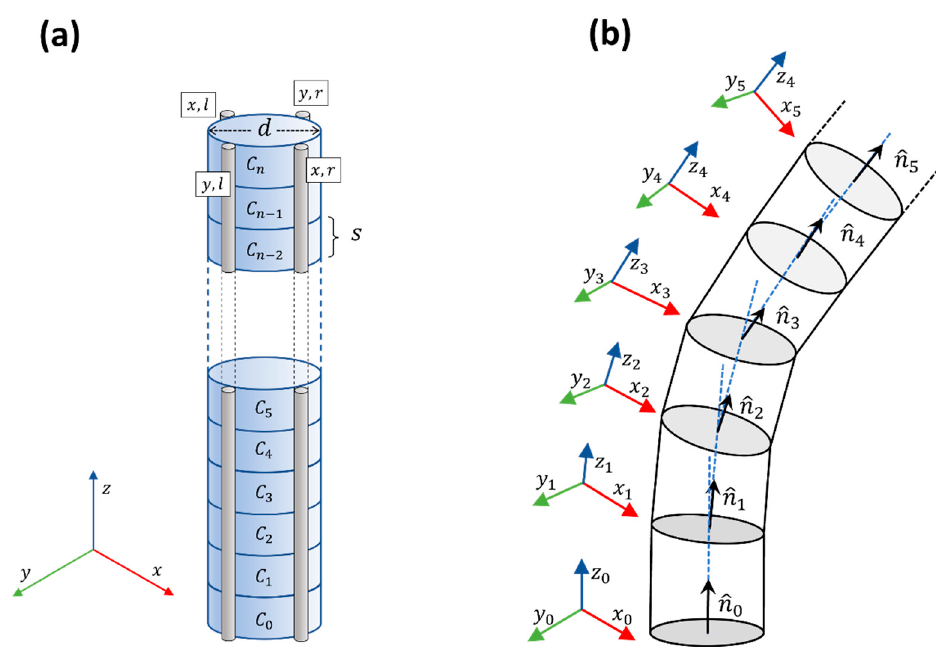
Figure 3. ( a ) Disposition of the fibers fixed along the length of the needle. Two fibers, tagged as x , l and x , r lie on the plan xz , while two fibers, tagged as y , l and y , r lie on the plan yz ; ( b ) fiber bending is calculated as an incremental rotation of the normal vector ˆ n i in every fiber sector defined as a needle portion between two sensing points.